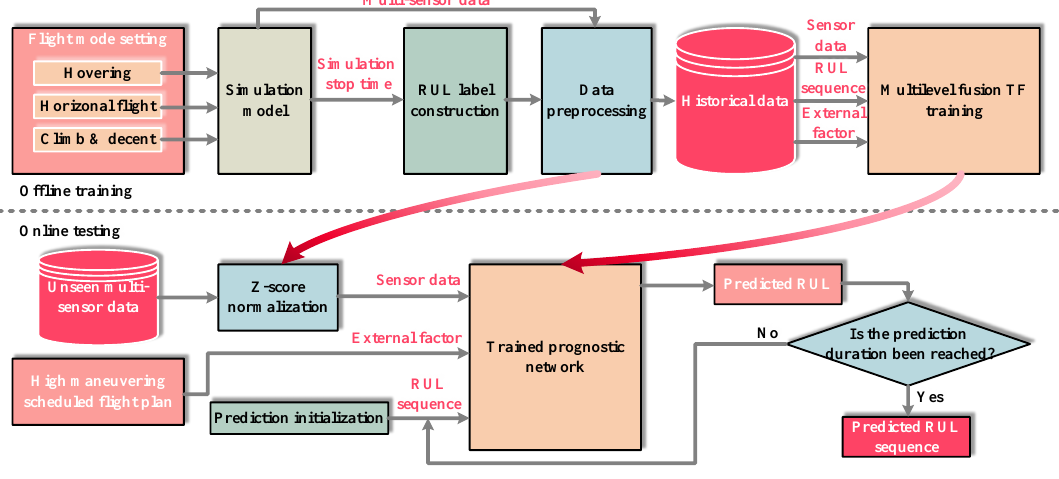
Figure 1. A graphic overview of the two-phase prognostic methodology. In the online testing phase, unseen multi-sensor data are directly input into the trained prognostic model only after normalization. At the same time, the scheduled flight